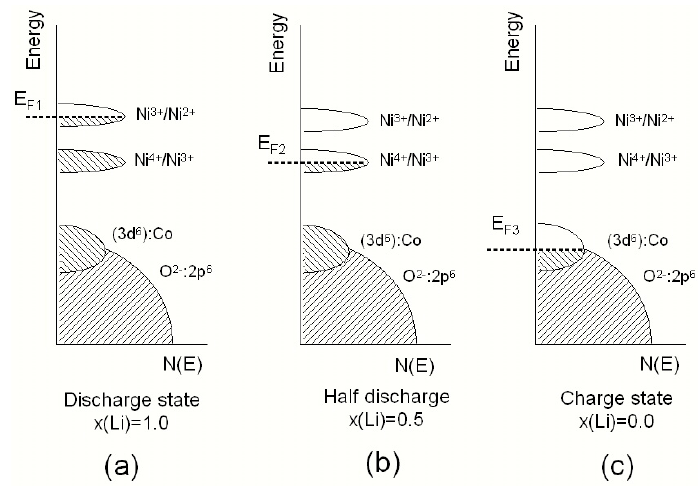
Figure 2. Schematic representation of the energy diagram vs. density of states for Li x Ni 1/3 Mn 1/3 Co 1/3 O 2 at different charge states. The Fermi level of the cathode material is represented for three state of charge. ( a ) Full discharge; ( b ) half discharge; ( c ) full charge.